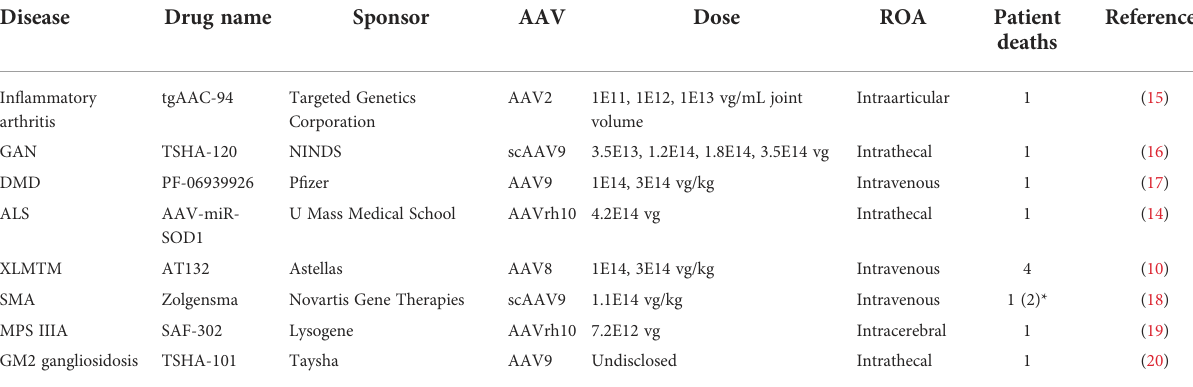
TABLE 1 Patient death cases that occurred in AAV